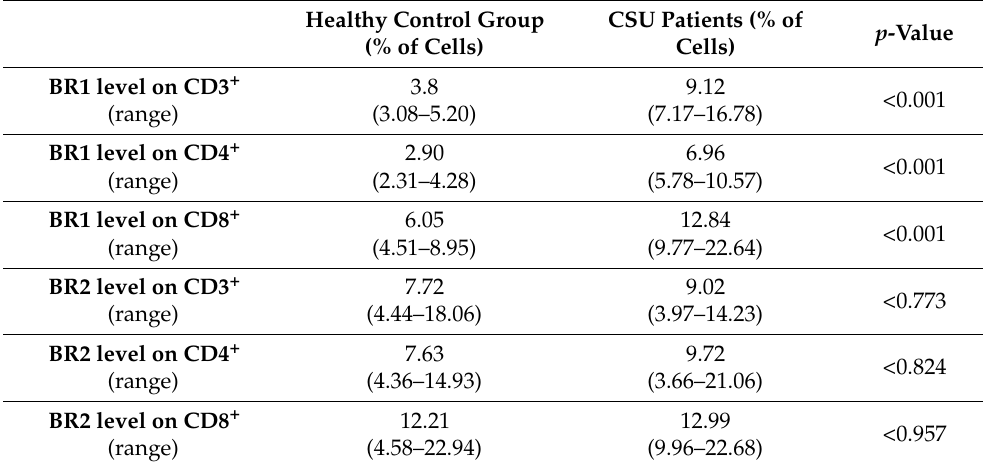
Table 3. Median of bradykinin receptor 1 and 2 expression in CD3 + , CD4 + , and CD8 + cells. Statistical significance of the results was analyzed with a Mann–Whitney